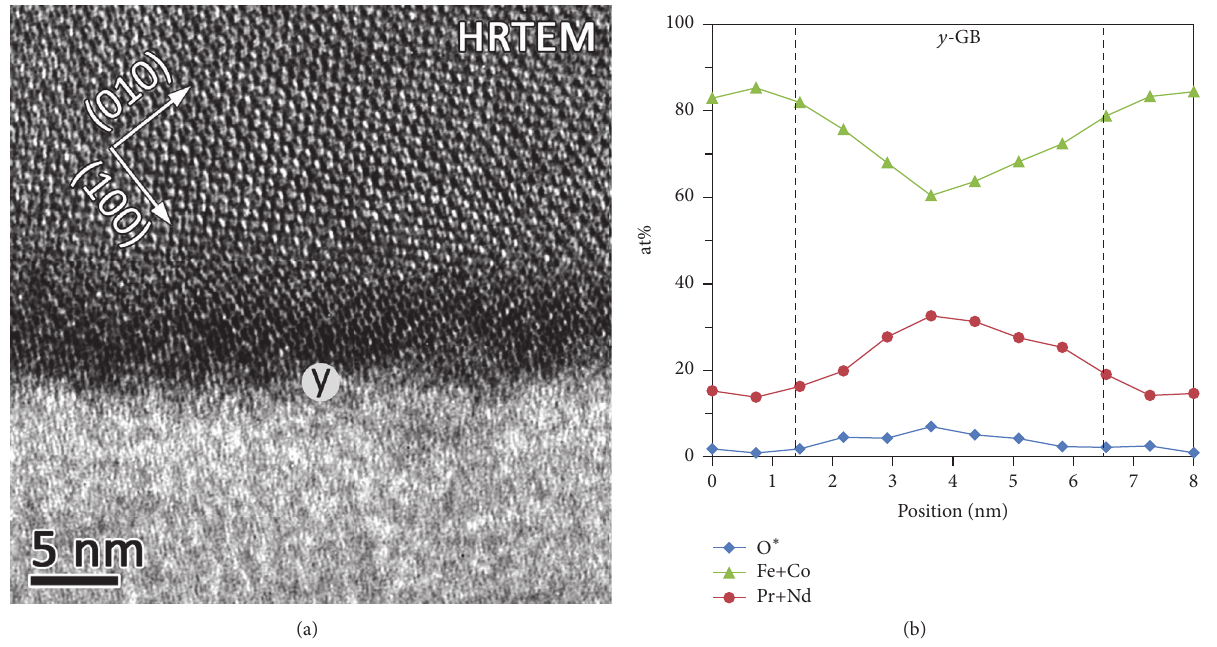
Figure 7: (a) HRTEM of y-GB, (100) and (010) lattice fringes of the top grain are visible, [ 001] zone axis; (b) EELS line scan across 𝑦 -GB; a significant increase of RE in the GB